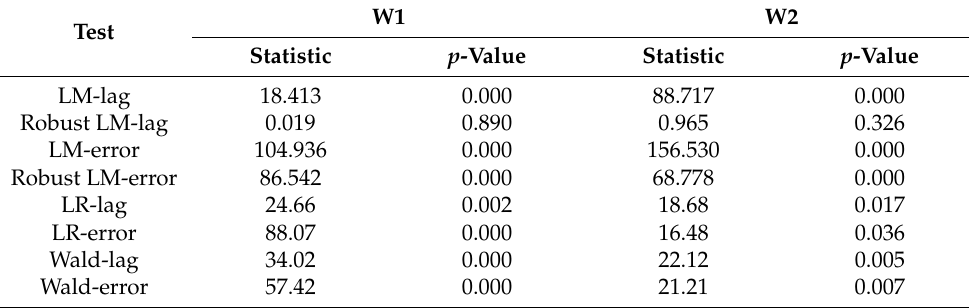
Table 4. Test results of model selection.